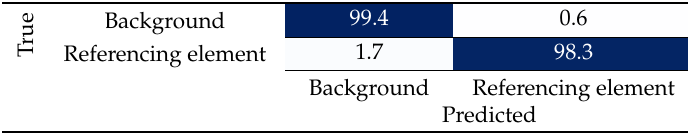
Table 4. Global confusion matrix